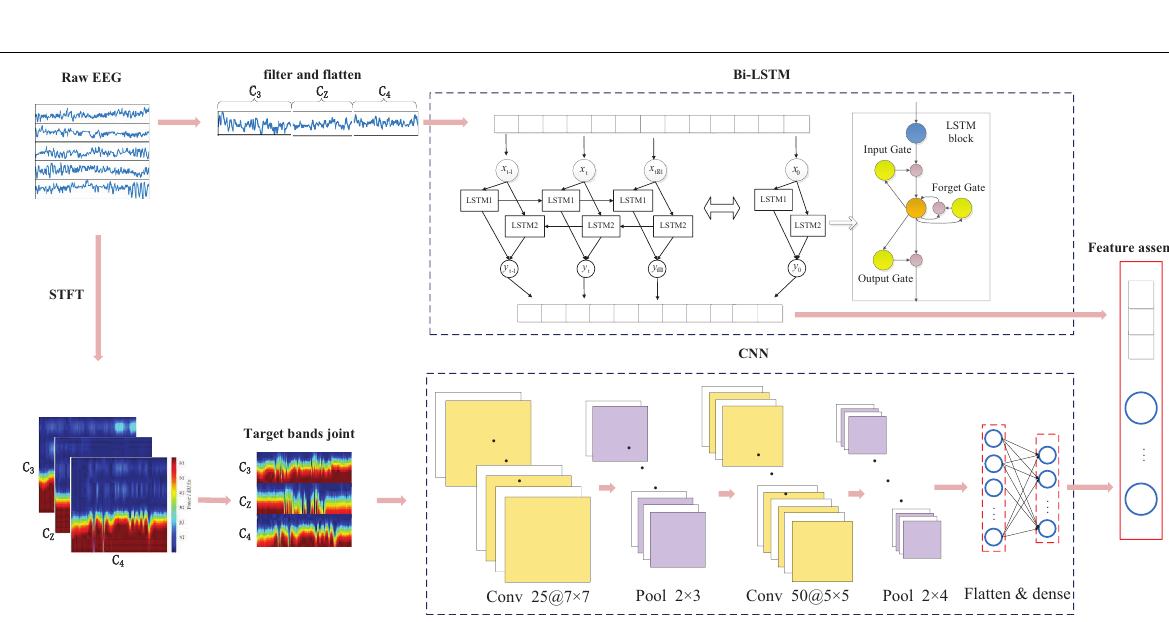
Frontiers in Neuroscience |